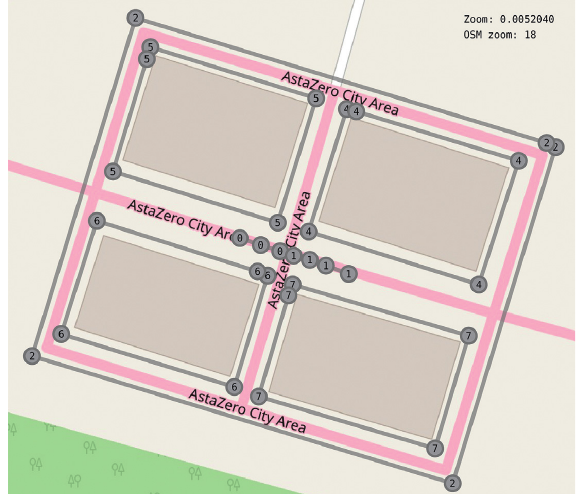
Figure 6: A driving area defined by route with ID 2 with the cutouts 4, 5, 6, and 7. Route 1 is the recovery route and route 0 is the start trajectory. The route IDs are written in the vertex circles of the